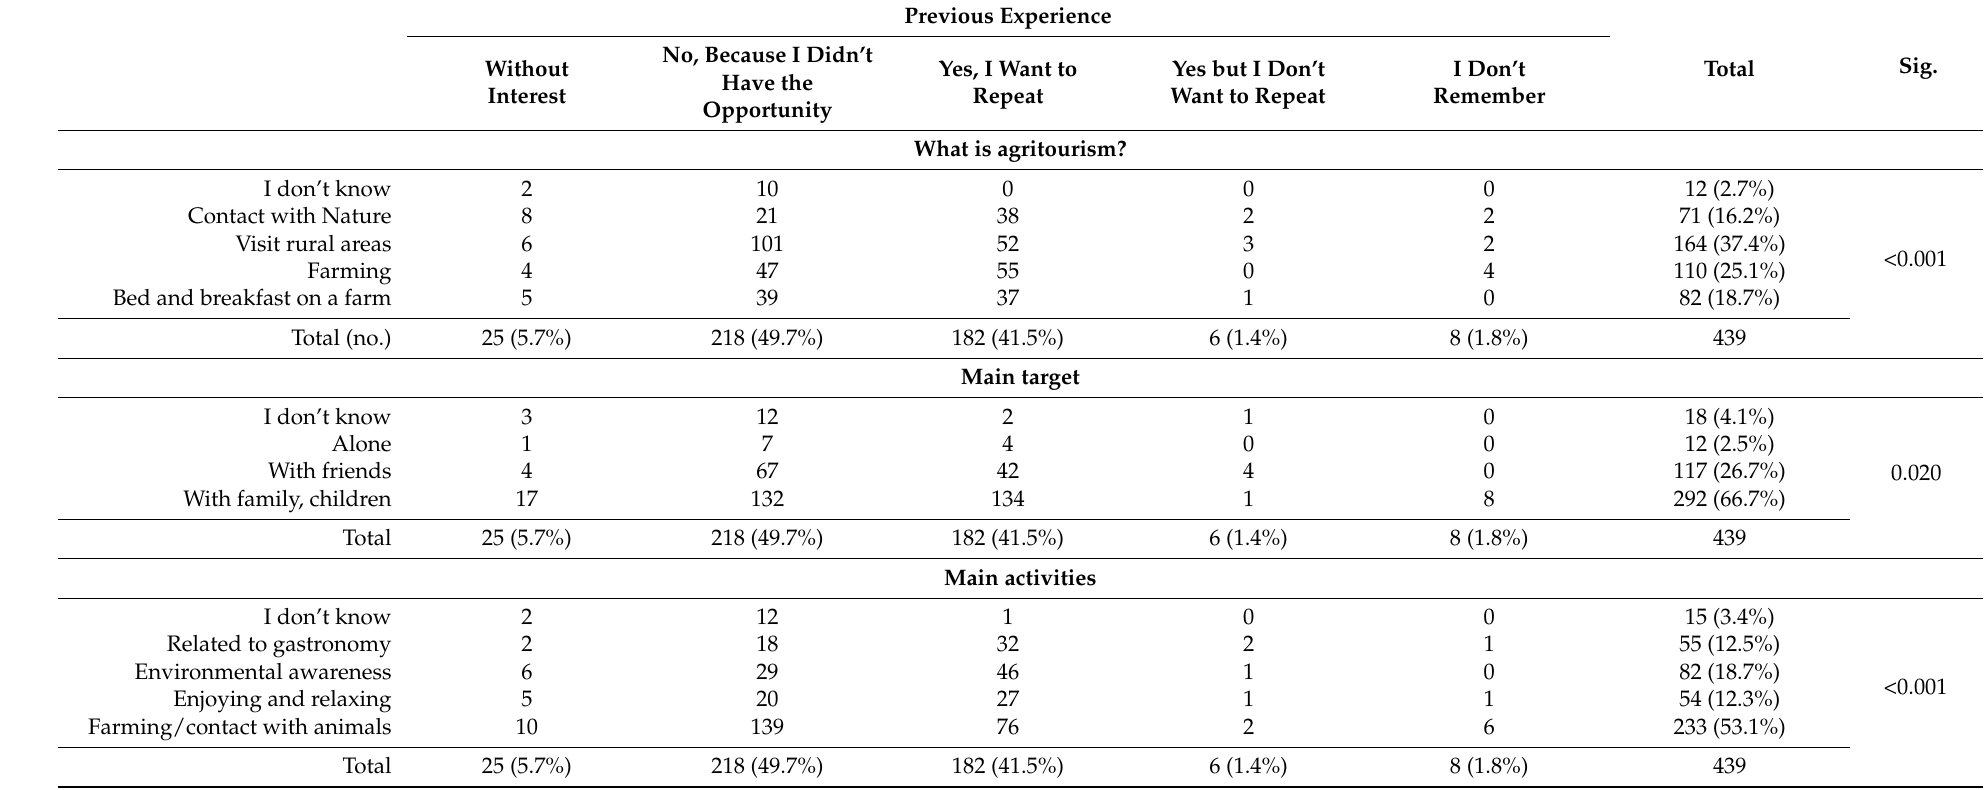
Table 5. Relationships between agritourism concept perceptions and previous